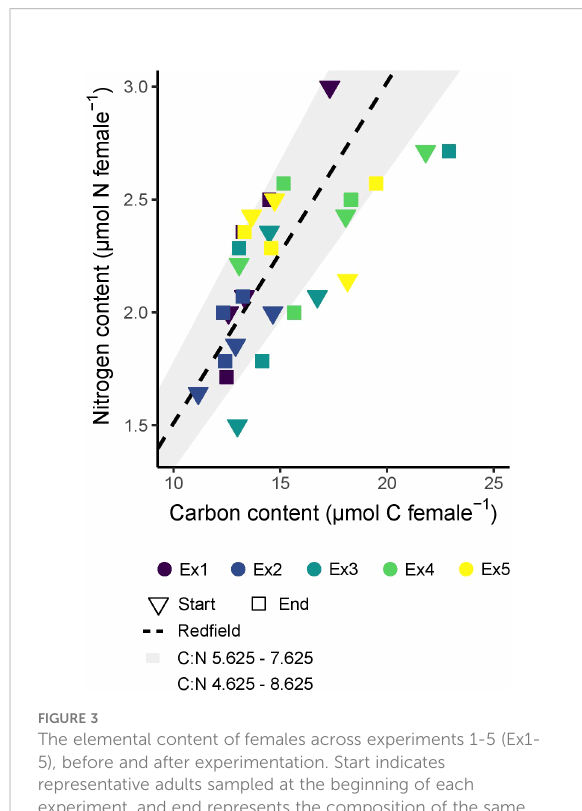
FIGURE 3 The elemental content of females across experiments 1-5 (Ex1- 5), before and after experimentation. Start indicates representative adults sampled at the beginning of each experiment, and end represents the composition of the same cohort of adults used in the experiments. ‘ Red fi eld ’ is the Red fi eld ratio (Red fi eld, 1958) found between carbon and nitrogen in phytoplankton (6.625 by